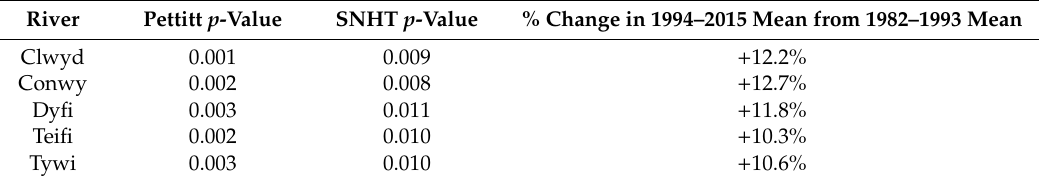
Table 3. Pettitt and SNHT method breakpoint analysis statistics for shown stepped increase in annual average autumn temperatures since 1994 in all study catchments.